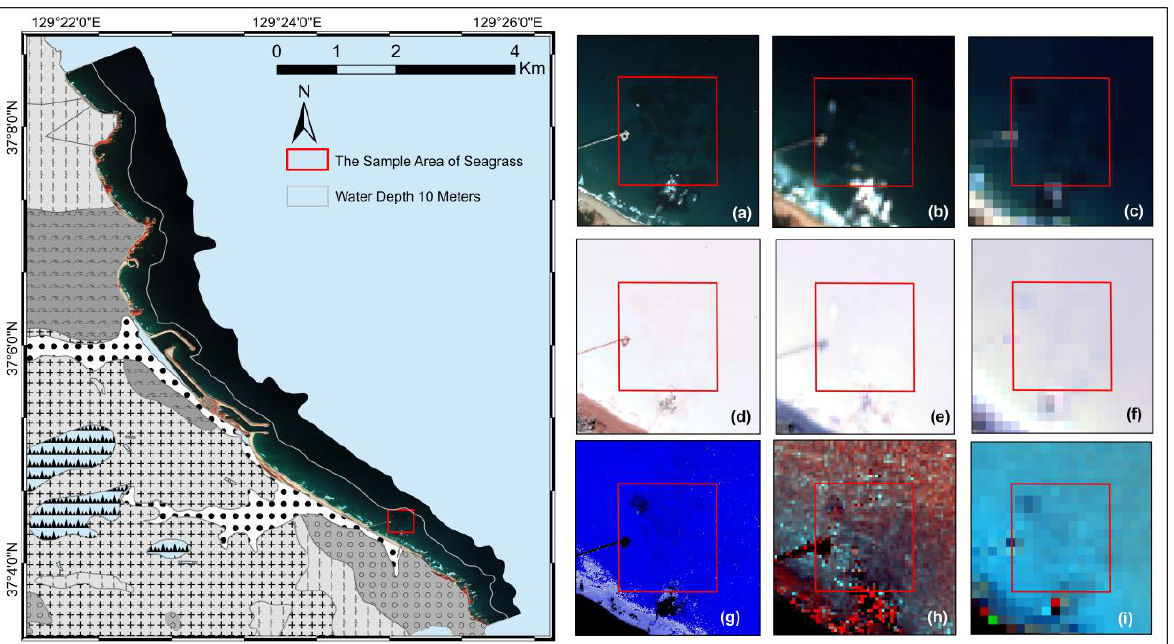
Figure 2 . Impact of atmospheric, sun-glint, and water column corrections on the Uljin–gun area: ( a ) atmospheric correction of GeoEye-1, ( b ) atmospheric correction of Sentinel-2, ( c ) atmospheric correction of Landsat-8, ( d ) sun-glint corrections of GeoEye-1, ( e ) sunglint corrections of Sentinel-2, ( f ) sunglint corrections of Landsat-8, ( g ) water column corrections of GeoEye-1 ( h ) water column corrections of Sentinel-2, and ( i ) water column corrections of Landsat-8 .